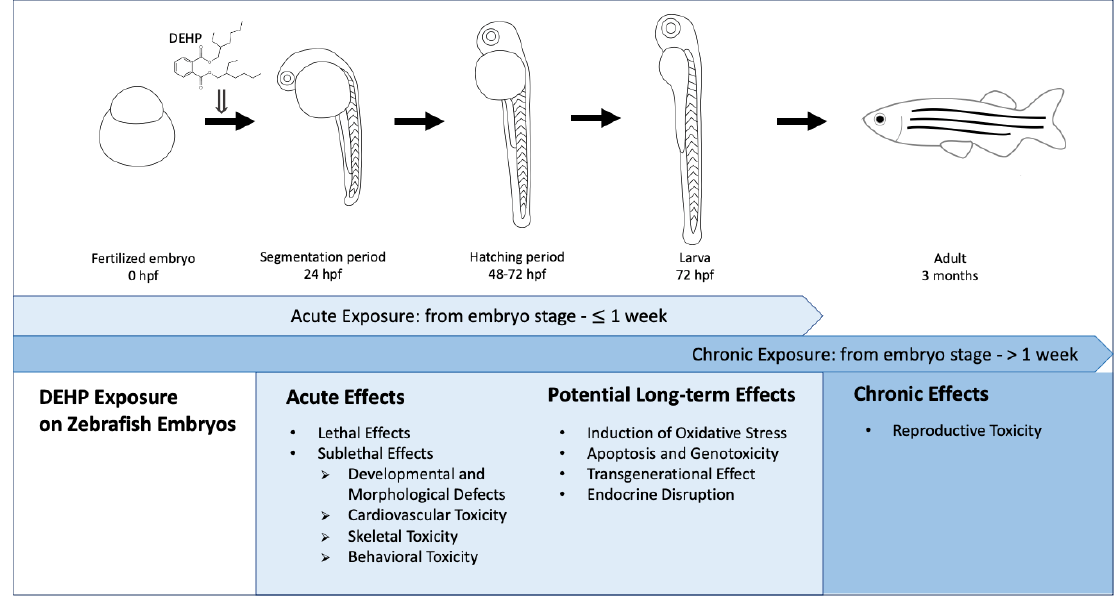
Figure 3. Effects of acute (from embryo stage to ≤ 1 week) and chronic (from embryo stage to > 1 week) DEHP exposures on zebrafish, which started from the embryonic stage to different developmental stages of the zebrafish [35]. (hpf: hours post-fertilization).